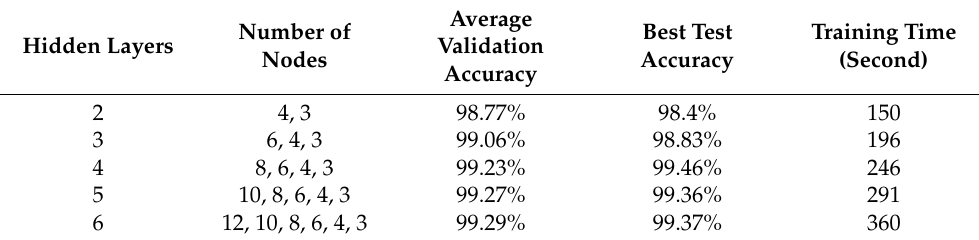
Table 4. Performances of FCNN models with different hidden